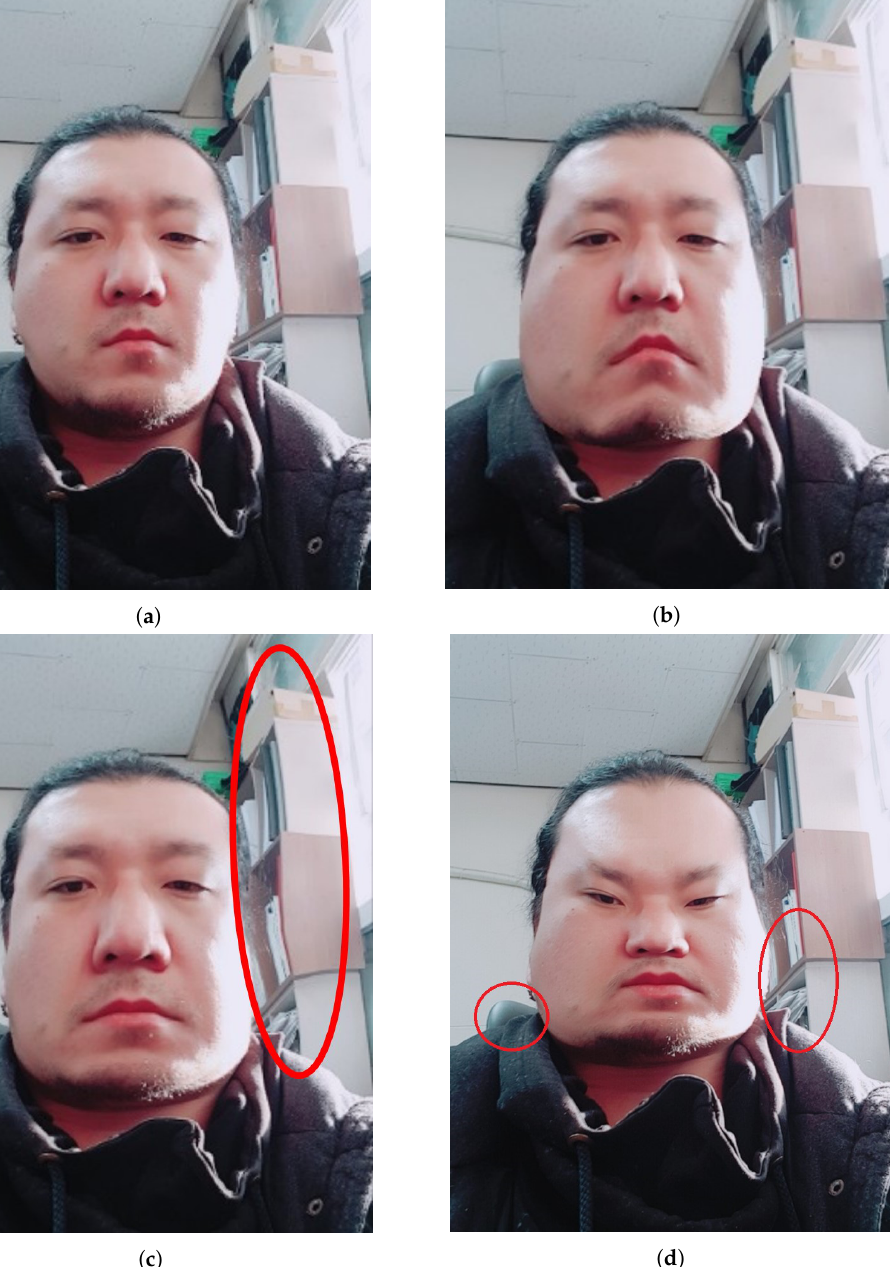
Figure 1. Results of face manipulation: ( a ) original image; ( b ) proposed framework; and comparison with existing applications: ( c ) Plastic Surgery Simulator; and ( d ) Snow. Red circles indicate image distortions incurred by